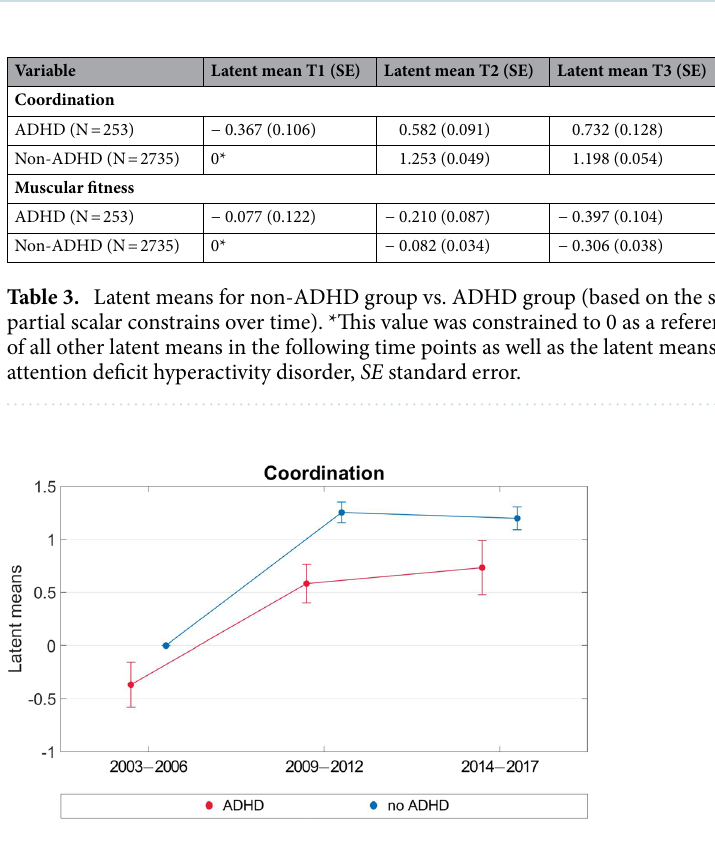
Figure 3. Multi-group analyses for development of coordination (2003–2017).